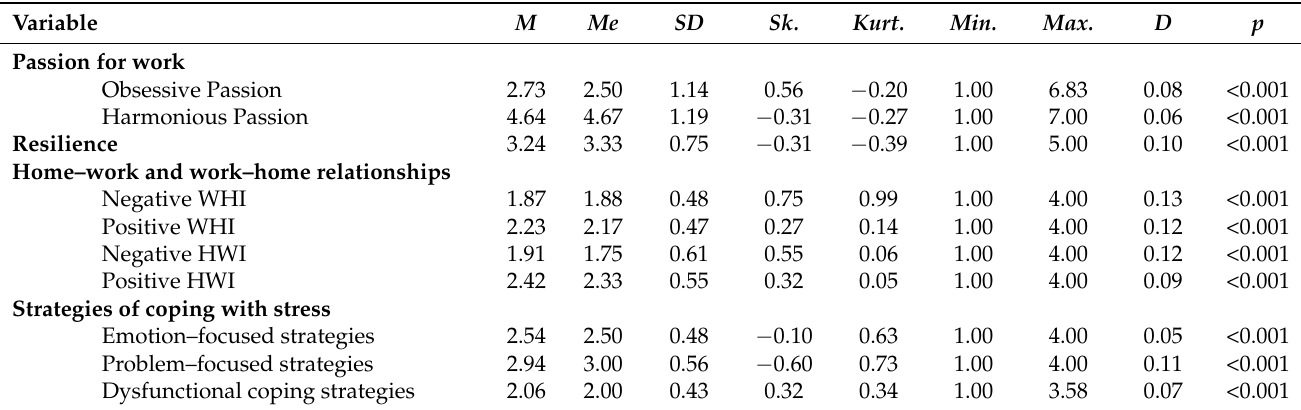
Table 2. Descriptive statistics together with the Kolmogorov–Smirnov test of normality of distribution (N = 1251).